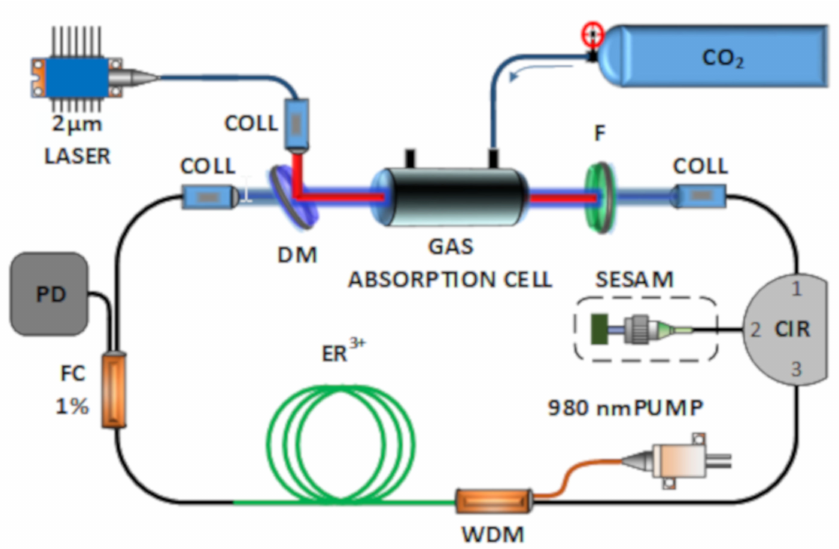
Figure 12. Experimental setup of the ML intracavity PT gas sensor. PD—photodiode, FC—fiber coupler with 1% out-coupling ratio, Er 3 + —80-cm-long erbium doped fiber, WDM—wavelength division multiplexer, PUMP—980 nm singlemode pump laser, CIR—fiber circulator, SESAM—fiber pigtailed semiconductor saturable absorber mirror, COLL—fiber collimator, F—filter, DM—dichroic mirror. The gas absorption cell is 10 cm long. Reprinted with permission from [16] C The Optical